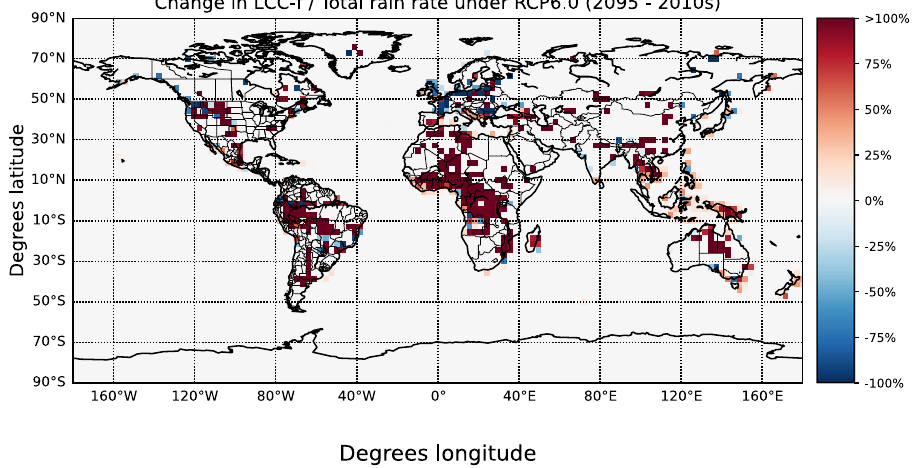
Fig.3|Annualchanges(in%)ofthe10-hourlyaveragedratiobetweentheLong- Continuing-Current (LCC) lightning fl ash rate and the totalrain between 2010 and 2095. Changes are calculated as the difference between the Representative ConcentrationPathwayRCP6.0andpresent-daysimulationsingridcellswherethe